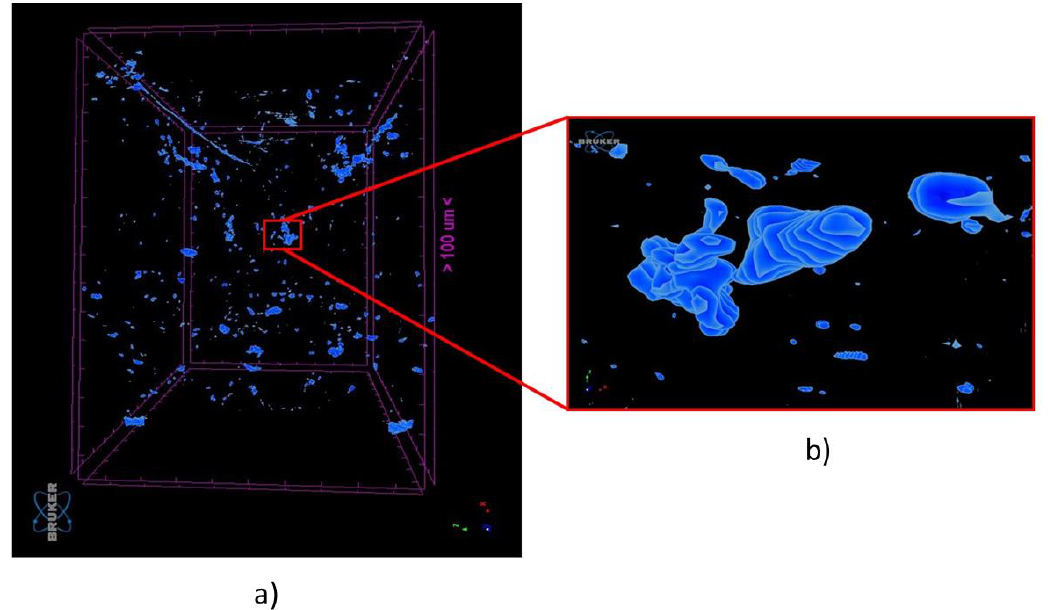
Figure 1. Image of mGO agglomerates ( a , b ) contained in HMWPE-UHMWPE. The images were obtained from analyses of HMWPE-UHMWPE (20 wt.%)-mGO (0.1 wt.%) nanocomposites using X-ray microtomography.